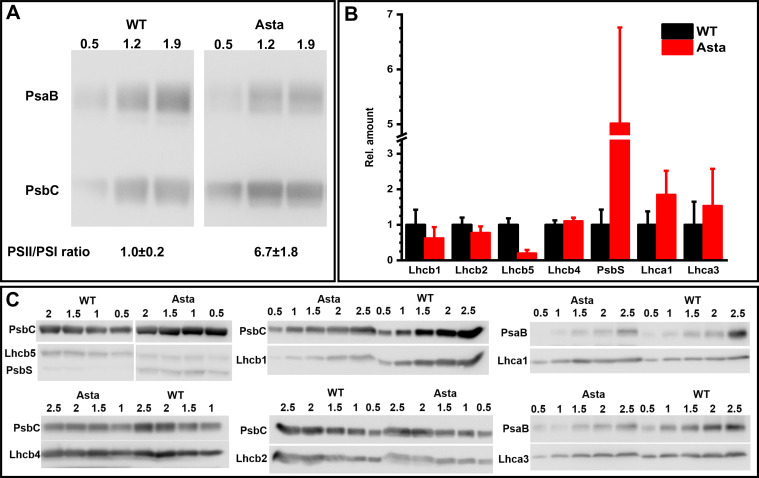
Comparison of the protein composition of WT and Asta plants.(A) Immunoblot with antibodies against PsaB (PSI subunit) and PsbC (PSII subunit) to determine the PSI/PSII ratio. Thylakoids equivalent to 0.5, 1.2 and 1.9 μg (left to right) Chl were loaded in the three lanes. The PSII/PSI ratio in the mutant was normalized to the WT PSII/PSI ratio. (B) Relative amount of LHC. The amount of each Lhc was determined by the immunoblottings shown in (C). The values are normalized to one of the core proteins (PsbC for Lhcbs and PsaB for Lhcas that were used as internal standards in all blots) and then double normalized to their WT level (Average values ± SD are shown, n = 3 or four technical replicas). (C) Thylakoid membranes containing 0.5–2.5 μg of Chl were loaded in each lane. The Lhc and the core proteins were detected on the same membrane that were developed with the two antibodies. Saturated signals were excluded from the analysis.